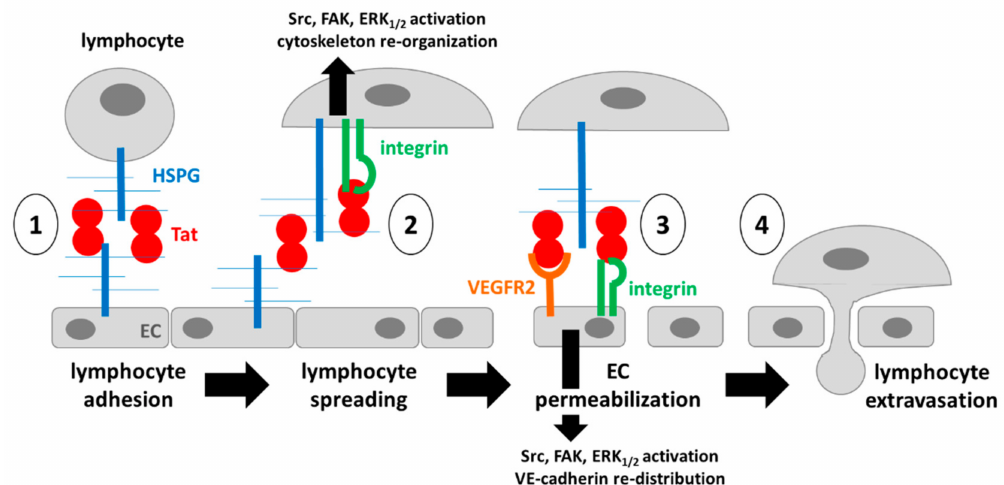
Figure 6. Schematic representation of the setting up of multimeric complexes orchestrated by Tat and HSPGs at the lymphocyte-endothelium interface: (1) in trans HSPG/Tat-Tat-HSPG quaternary complex necessary for the preliminary adhesion of lymphocytes to the endothelium; (2) in cis HSPG/Tat/integrin on the lymphocyte responsible for cell spread- ing; (3) in trans HSPG-Tat-VEGFR2 and HSPG-Tat-integrin interactions responsible for VE-cadherin redistribution and endothelial permeabilization that, together with the interaction mentioned at point (2), is responsible for lymphocyte extravasation